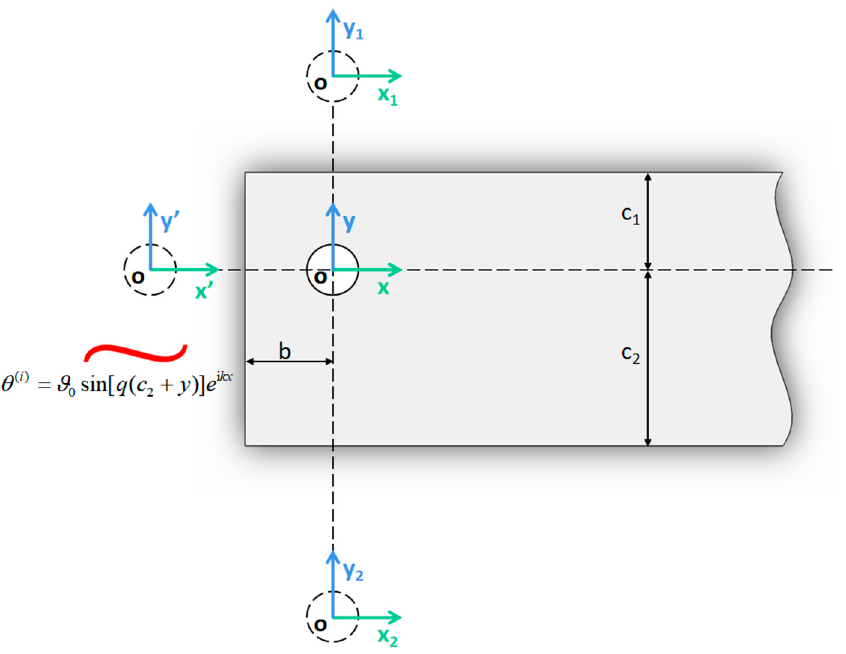
Figure 3. Schematic diagram of two-dimensional pulse heating.